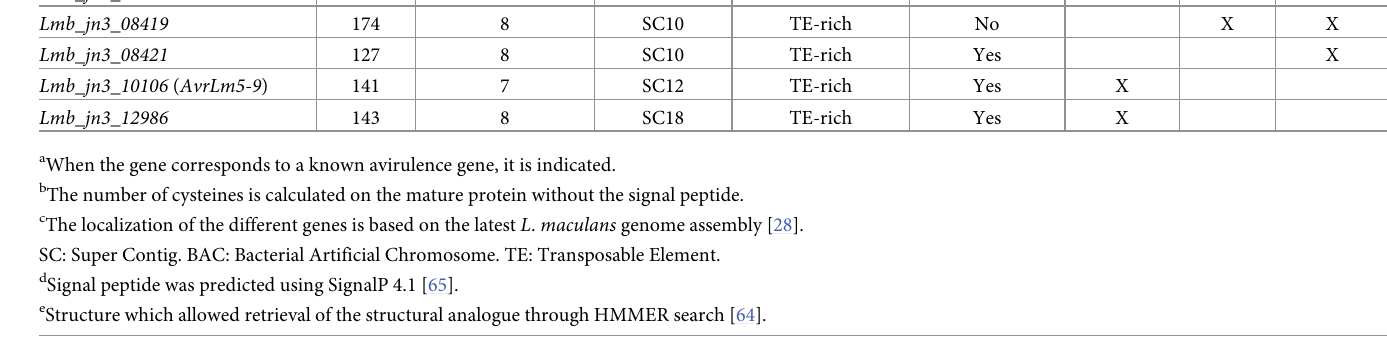
PLOS Pathogens| https://doi.org/10.1371/journal.ppat.1010664 July 6,